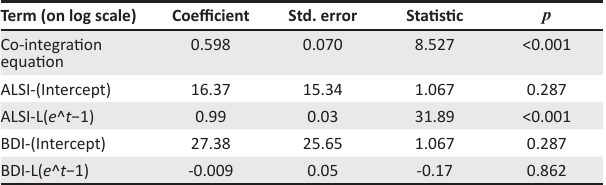
TABLE 3: Vector error-correction model results for the pre-break period, May 1985–June 2008. Term (on log scale) Coefficient Std. error